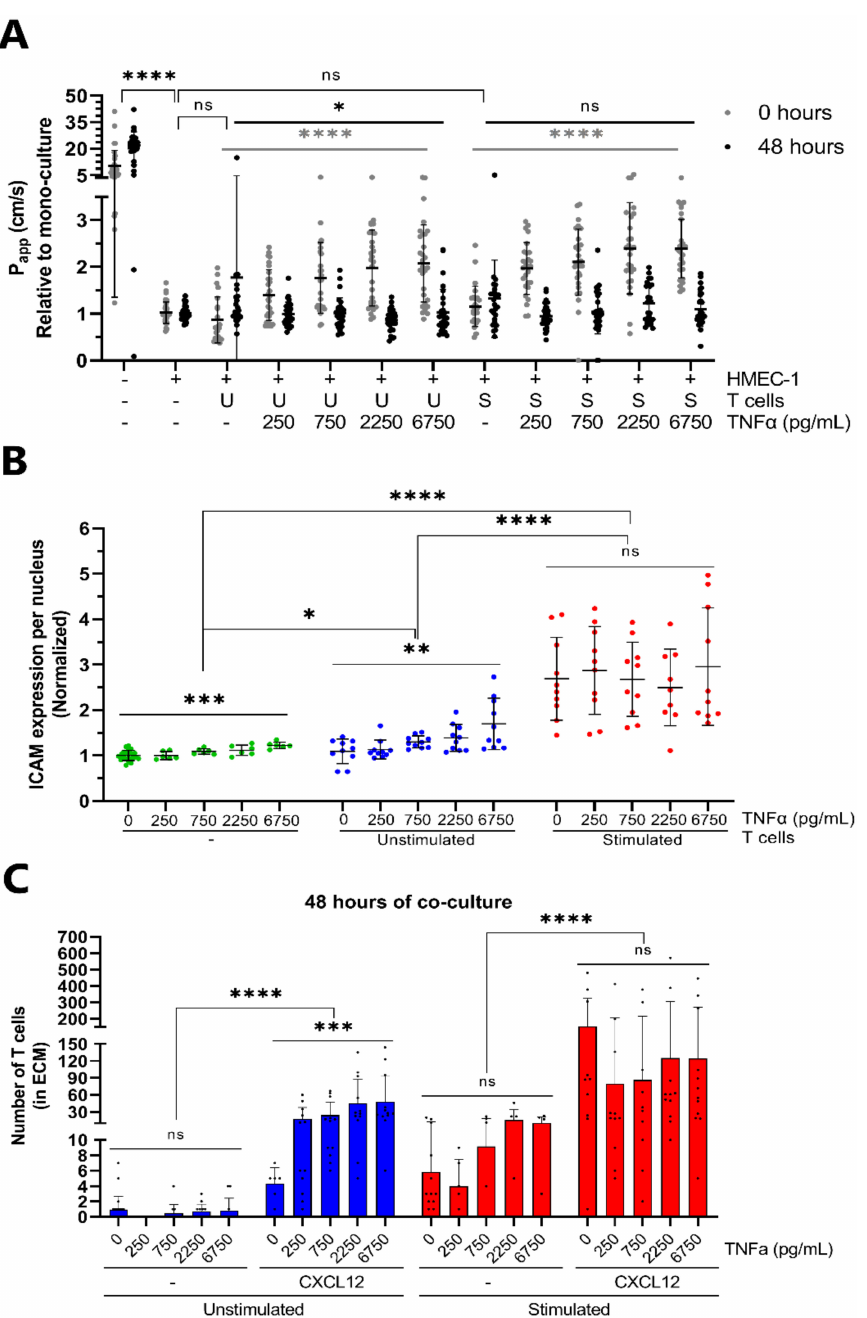
Figure 4. Inflammation potentiates migration of unstimulated T cells in response to CXCL12. ( A ) Barrier integrity of HMEC-1 vessels is affected by TNF α pretreatment. Apparent permeability (Papp) values are normalized against Papp values of mono-cultured HMEC-1 vessels. Shown are mean ± SD, and data points represent individual chips ( N = 6–13, n = 2–7). Statistical analysis was performed on non-normalized data. Data were log transformed and analyzed using